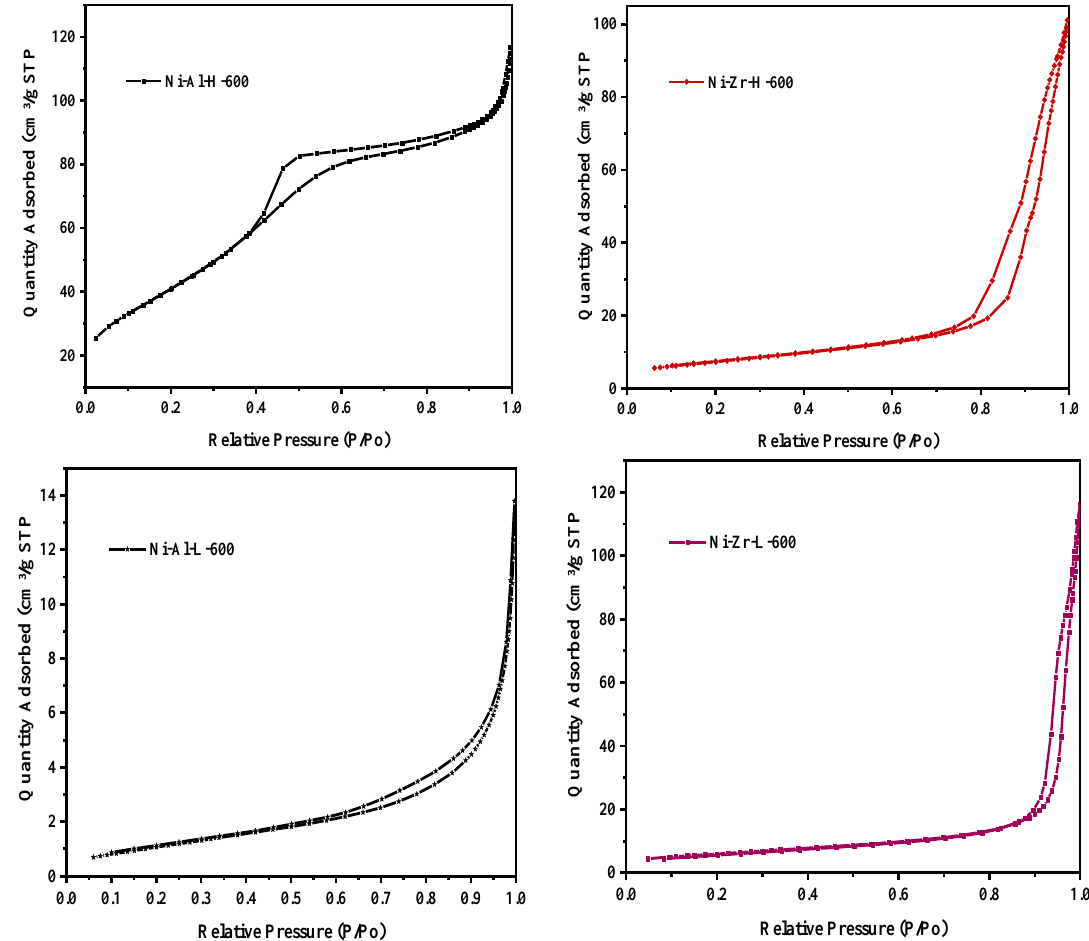
Figure 1. Nitrogen adsorption/desorption isotherms of fresh catalysts calcined at 600 °C.